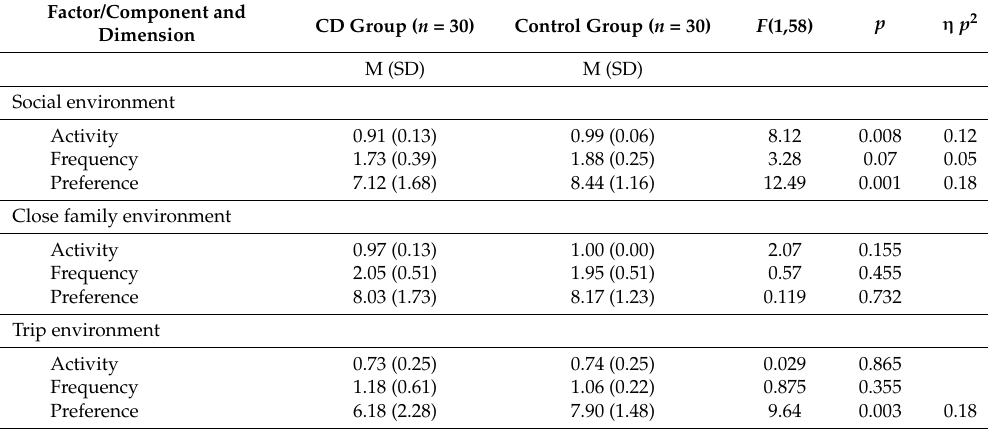
Table 3. Comparison between groups with and without CD across the four CD-Chart dimensions